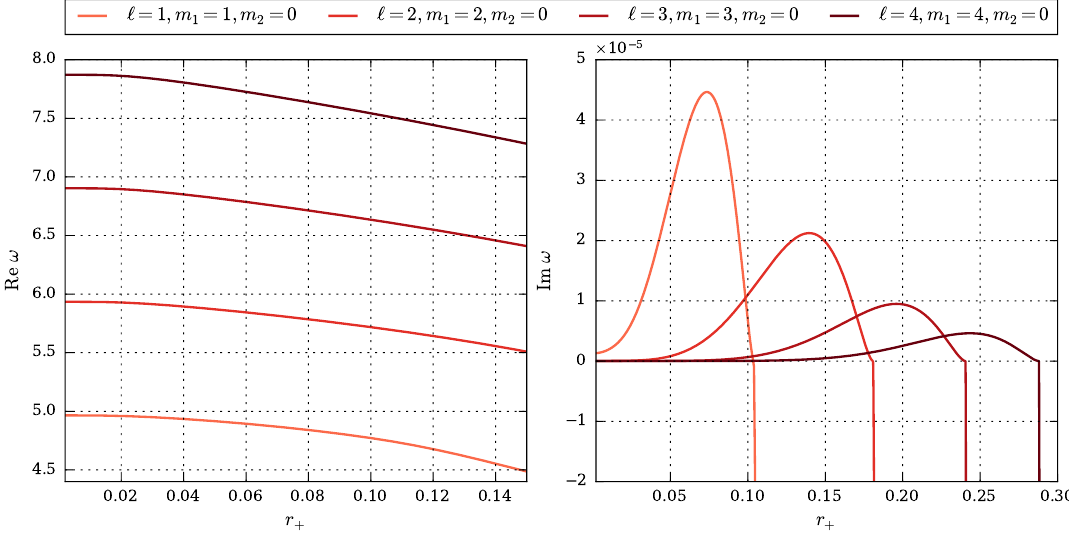
Figure 7 . The most unstable mode m 1 = ‘ as a function of r + for ‘ = 1 , 2 , 3 , 4 . Note that the smaller decay rate for larger values of ‘ is accompanied by a larger width of the superradiant window. The black hole is expected to decay through different values of ‘ , m 1 and m 2 depending on the values of its